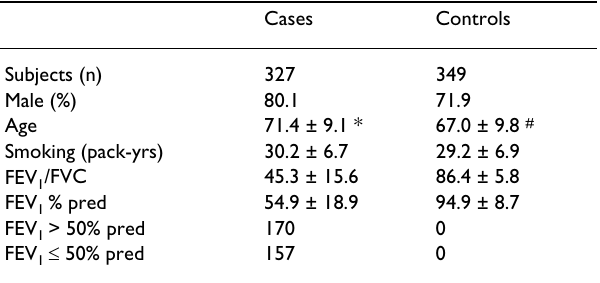
Table 1: The demographic character of study